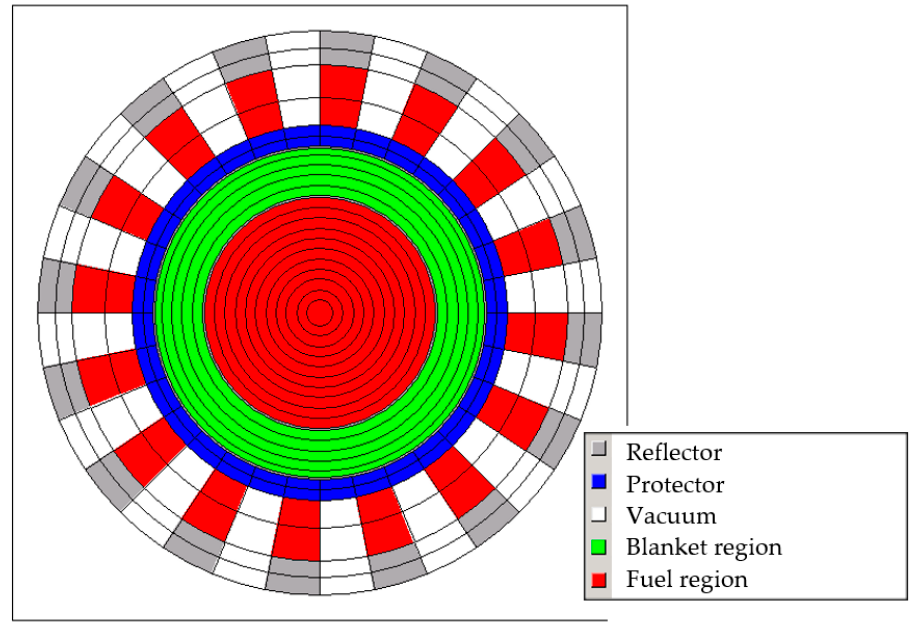
Figure 1. Volume corrected 2D HELIOS model of the molten salt reactor.